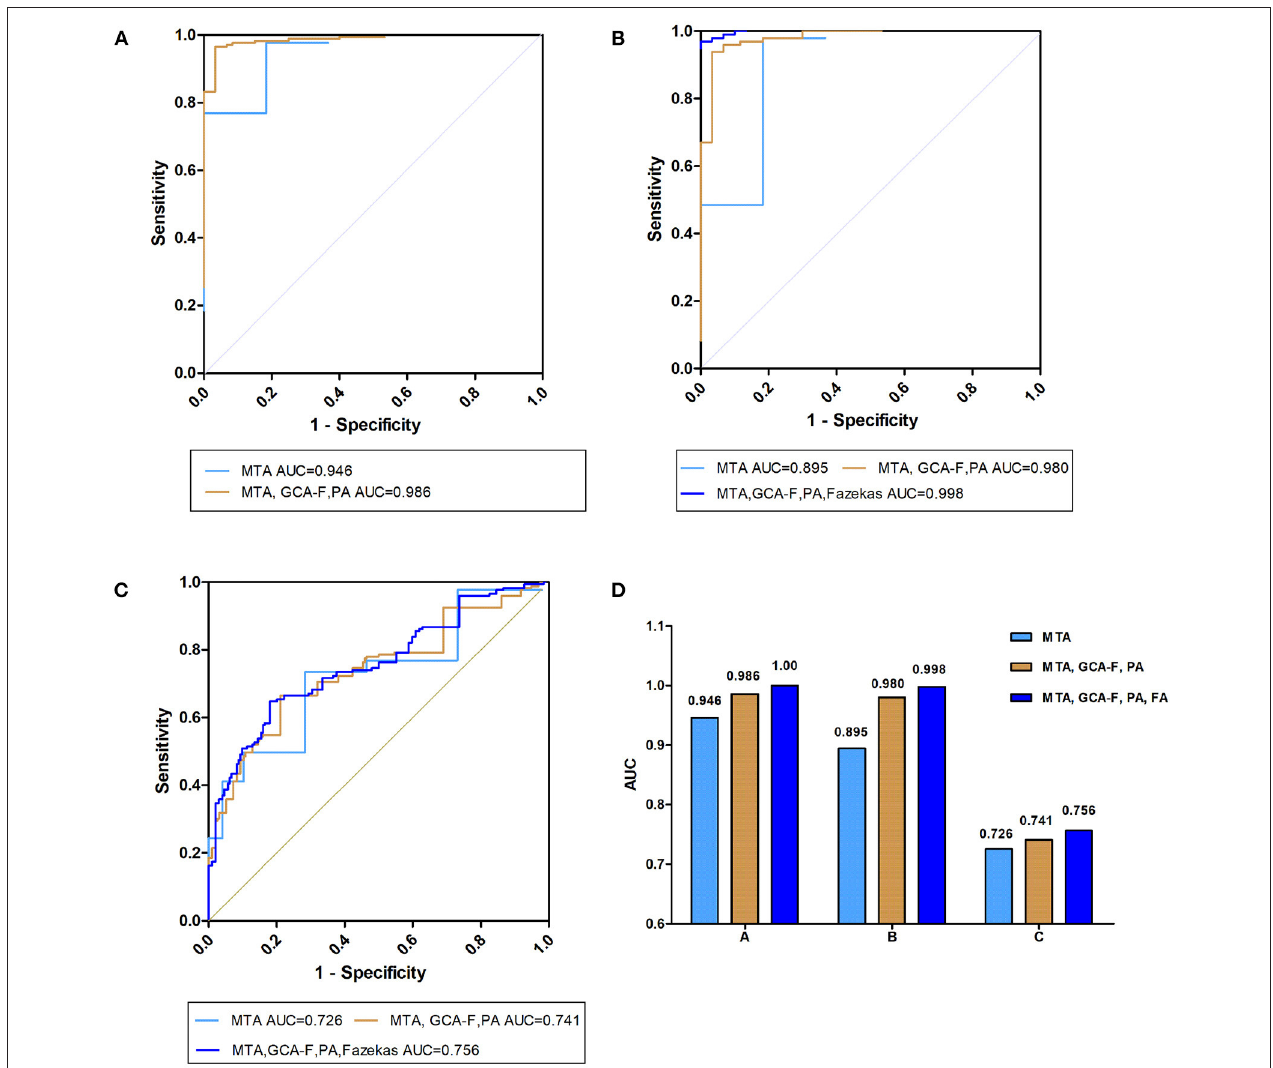
FIGURE 4 | Prediction of visual rating scale diagnostic performances. Receiver operating characteristic (ROC) curves presenting the predicting capacity of “visual rating scale” in (A) AD vs. NC, (B) DLB vs. NC, and (C) AD vs. DLB different research groups through the MTA visual rating scale (light blue curve), MTA, GCA-F and PA visual rating scale (brown curve) and the three above combined with Fazekas visual rating scales (dark blue curve). AD, Alzheimer’s disease; DLB, dementia with Lewy bodies; NC, normal controls; AUC, area under the curve; MTA, medial temporal lobe atrophy; GCA-F, global cortical atrophy-frontal subscale; PA, posterior